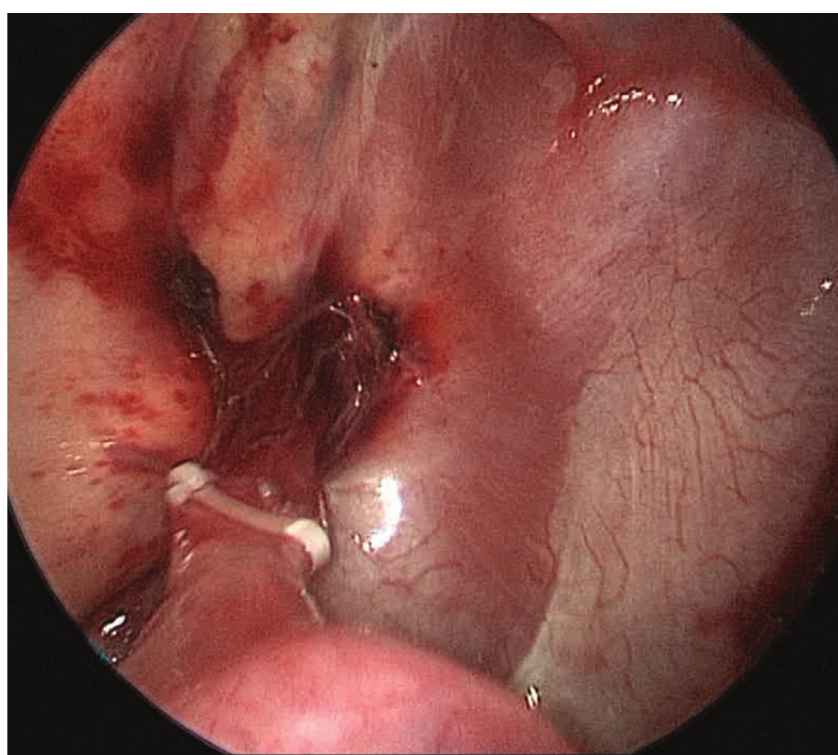
Fig. 4 Residual systemic vessel in the patient described as case 2, closed with Hem-o-Lock clip before division with Just-Right 5-mm